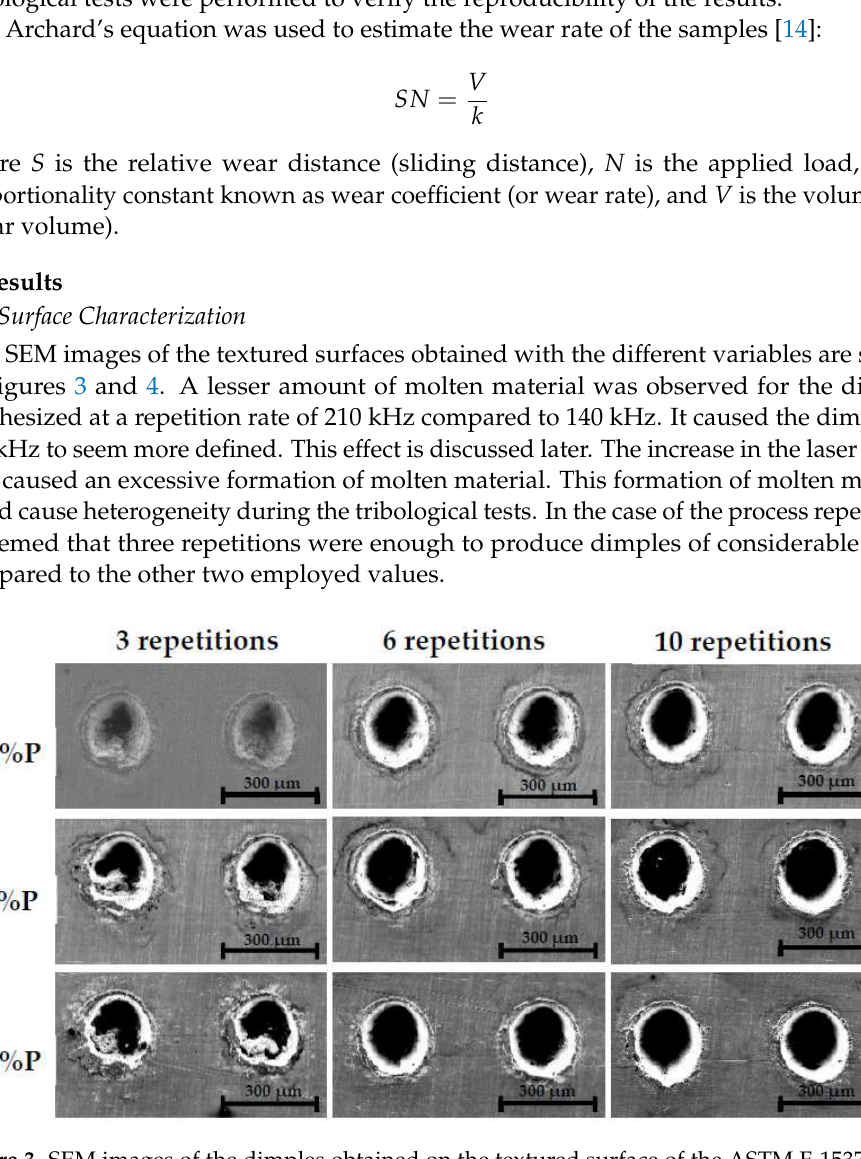
Table 3. Tribological test parameters.